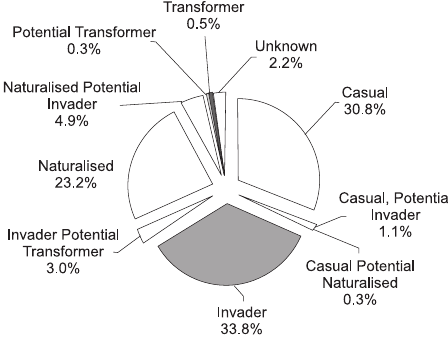
Fig. 2: Weed status of alien plant